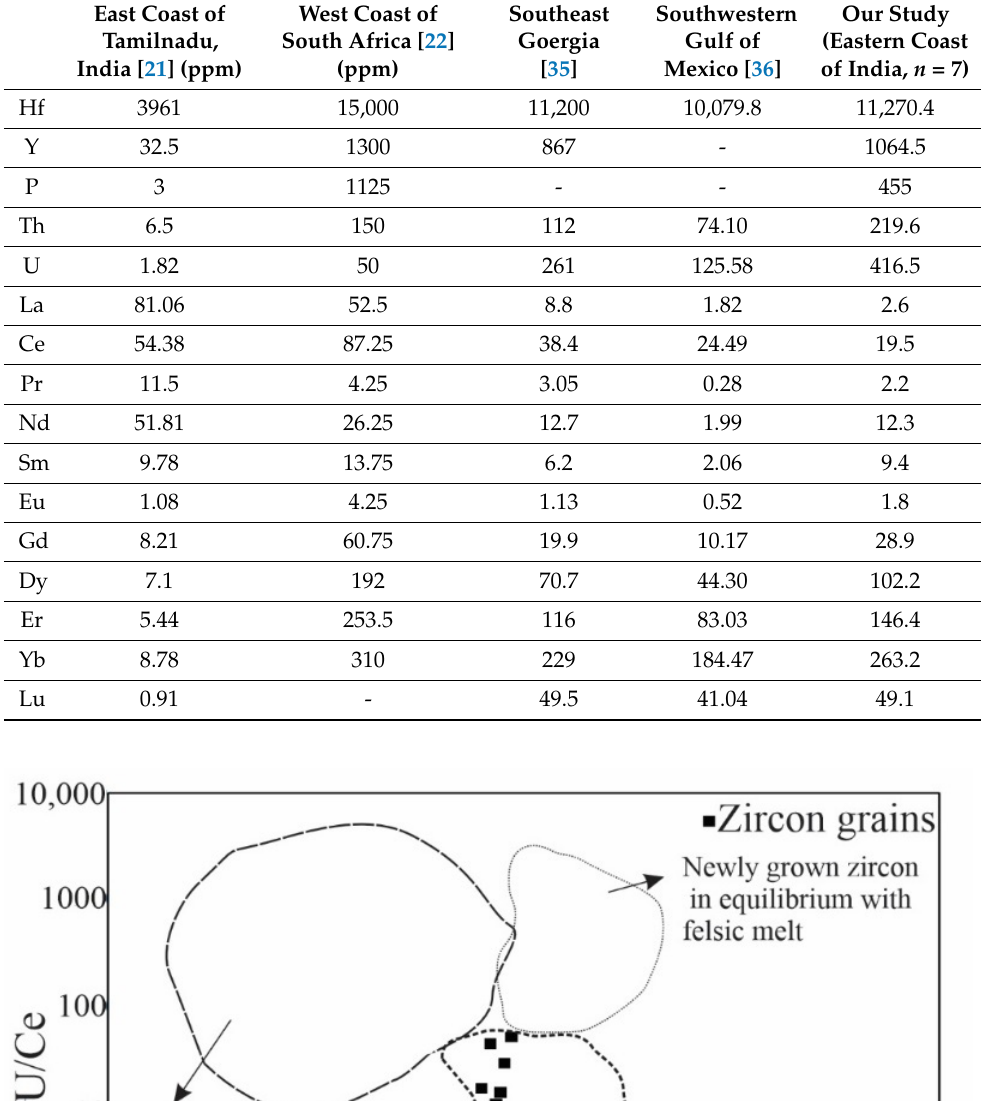
Table 2. Worldwide comparison of trace elements present in the zircon samples.